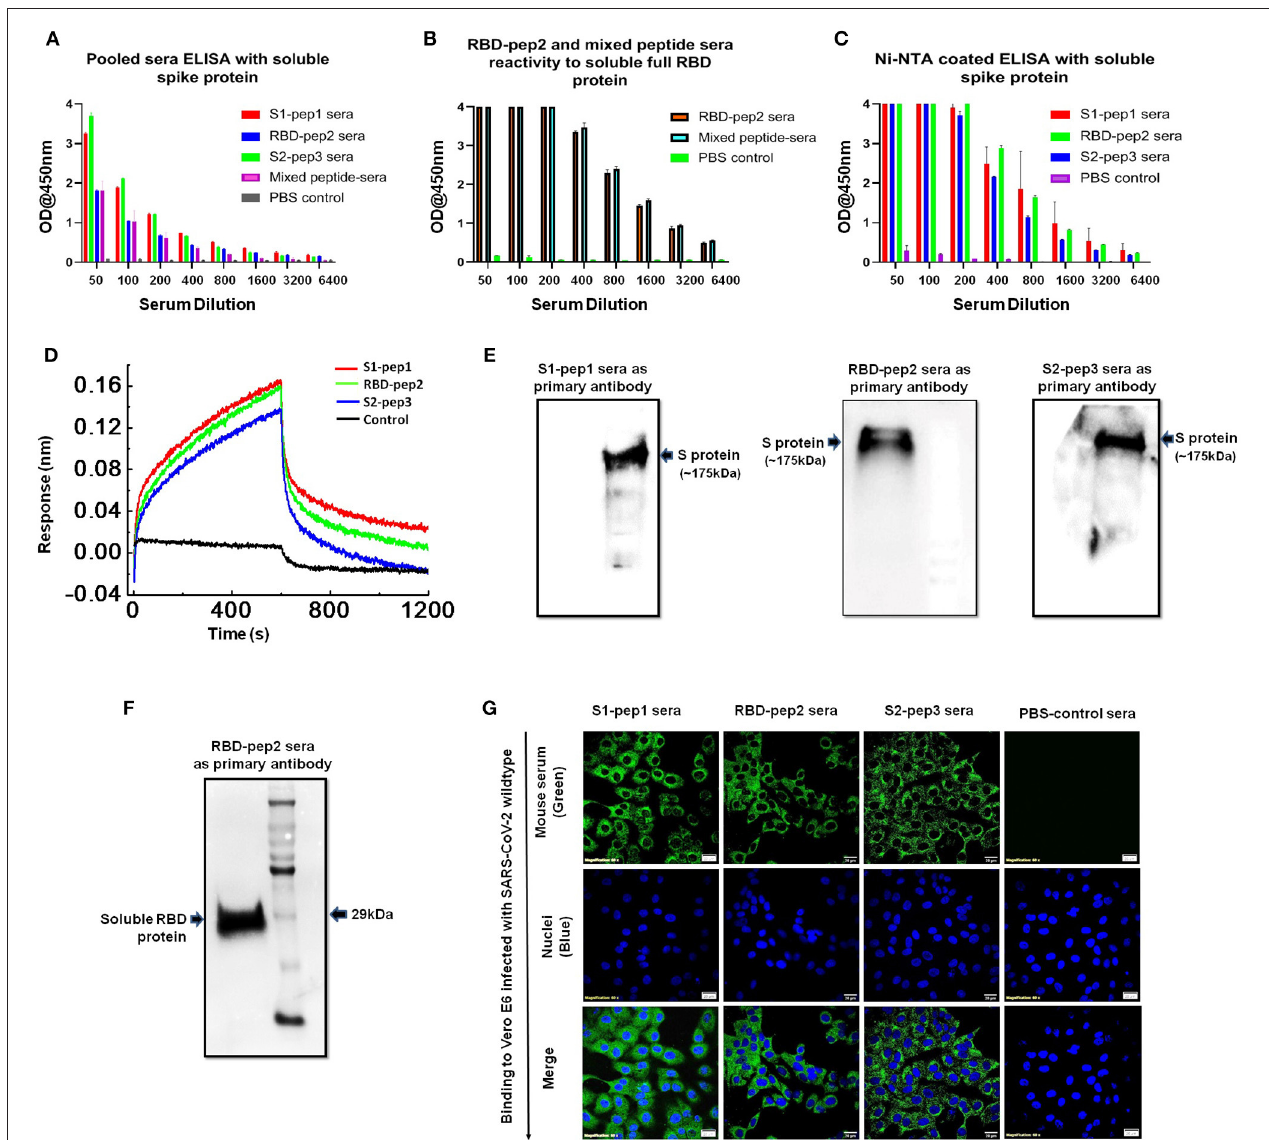
FIGURE 4 | Functional characterization of immunized sera. (A) Binding antibody titers of immunized pooled sera from S1-pep1 (red), RBD-pep2 (blue), S2-pep3 (green), and mixed peptide sera (pink) to the soluble spike protein. (B) Binding antibody titers of immunized sera from RBD and mixed peptide-immunized pooled sera to the soluble RBD protein. (C) Binding titers of pooled sera to Ni-NTA HisSorb-captured spike protein ELISA. (D) Real-time binding of soluble spike protein with the purified IgGs from immunized mice, S1-pep1 (red), RBD-pep2 (green), and S2-pep3 (blue). (E) The Western blot analysis of pooled immunized sera reactivity to soluble spike protein separated on SDS-PAGE (4–12%) gels. The pooled sera from S1-pep immunized group (lane), RBD pep (middle lane), and S2-pep (right lane) have been used as the primary antibody. (F) The Western blot analysis of pooled immunized sera from RBD-pep2 group as the primary antibody to soluble RBD protein separated on SDS-PAGE (4–12%) gels. (G) Immunofluorescence detection of pooled immunized peptide sera to wild type SARS-CoV-2 virus-infected Vero E6 cells. Immunized sera as the primary antibody and probed with secondary antibody. Alexa-Fluor 488-labeled anti-mouse antibody (green) (1:100). The nuclei were stained with 4 ′ ,6-diamidino-2-phenylindole (DAPI, blue); scale bar: 20 µ m and magnification